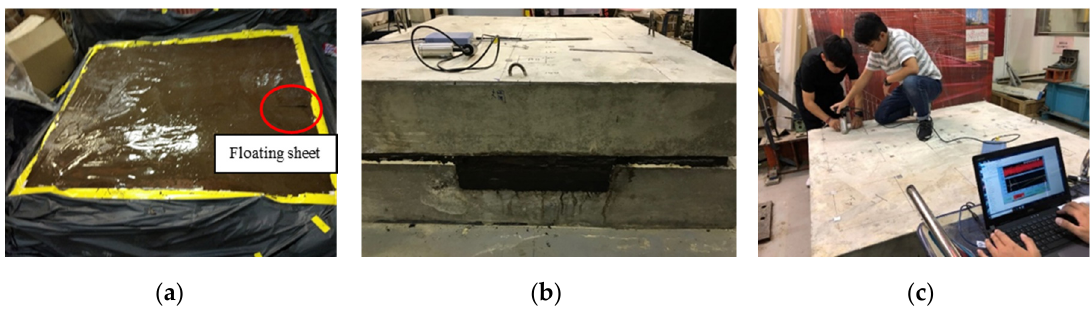
Figure 5. Specimen ( a ) during casting; ( b ) side view; ( c ) the IE test.